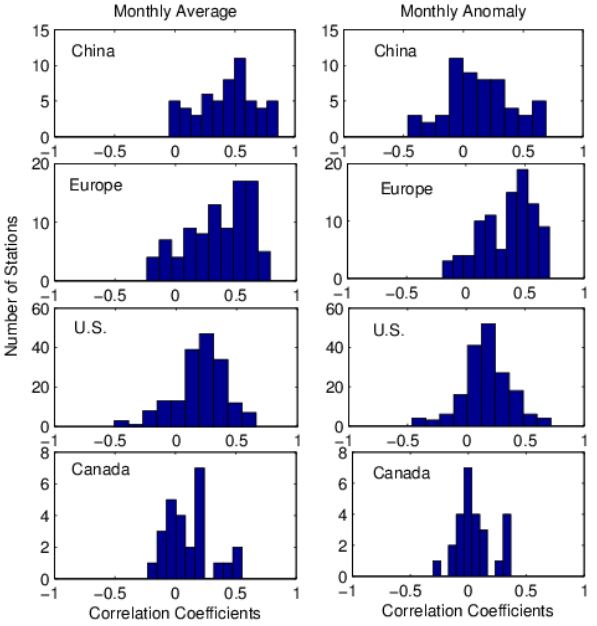
Figure 8. Same as Fig. 7 except that the long-term trends were removed from the Fig. 8. Same as Fig. 7 except that the long-term trends were re- monthly averages and monthly anomalies (seasonal cycle removed) of PM10 and moved from the monthly averages and monthly anomalies (seasonal optical extinction coefficients (inverse of visibility). cycle removed) of PM 10 and optical extinction coefficients (inverse of